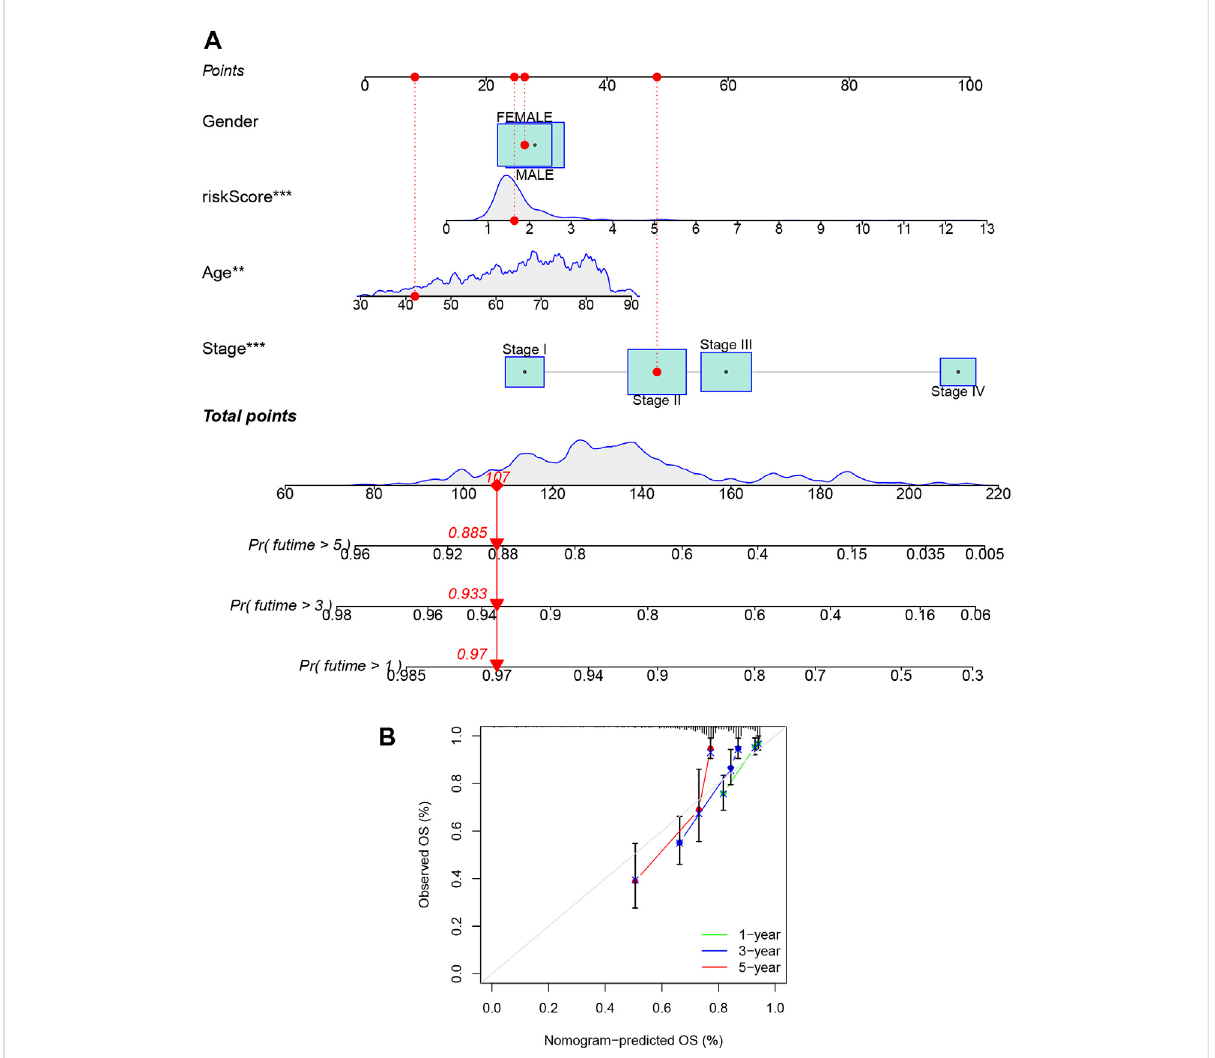
FIGURE 8 Construction and evaluation of a predictive nomogram. (A) The nomogram predicts the probability of overall survival at the 1-, 3-, and 5-year. (B) The calibration plot of the nomogram predicts the probability of the 1-, 3-, and 5-year overall survival. * p < 0.05; ** p < 0.01; *** p <